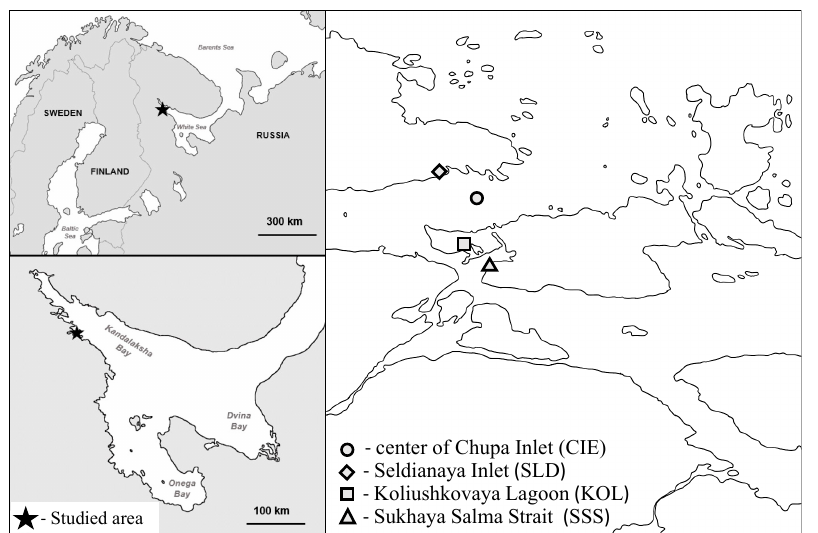
Figure 1. The study area. Table 1. Characteristics of abiotic and biotic conditions of the inshore sampling sites (see text for references).